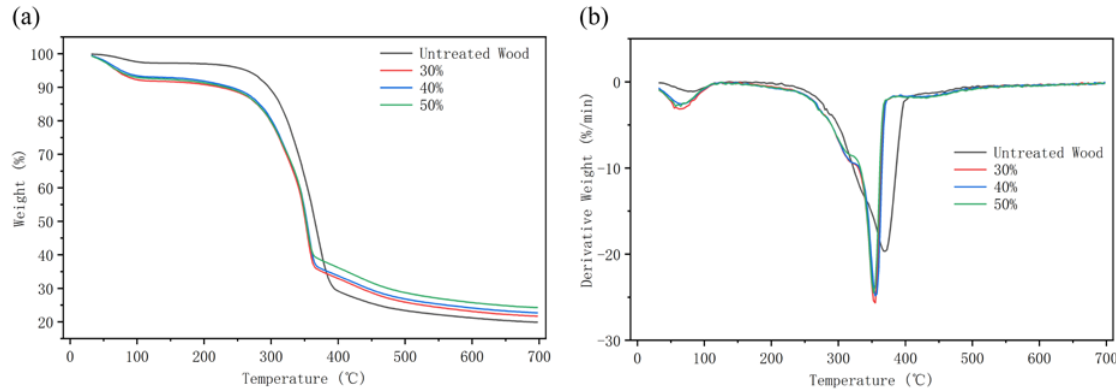
Figure 9. TG ( a ) and DTG ( b ) curves of untreated and furfurylated wood. Table 3. Pyrolysis weight loss of untreated and furfurylated wood at different temperature stages. Temperature/ ◦